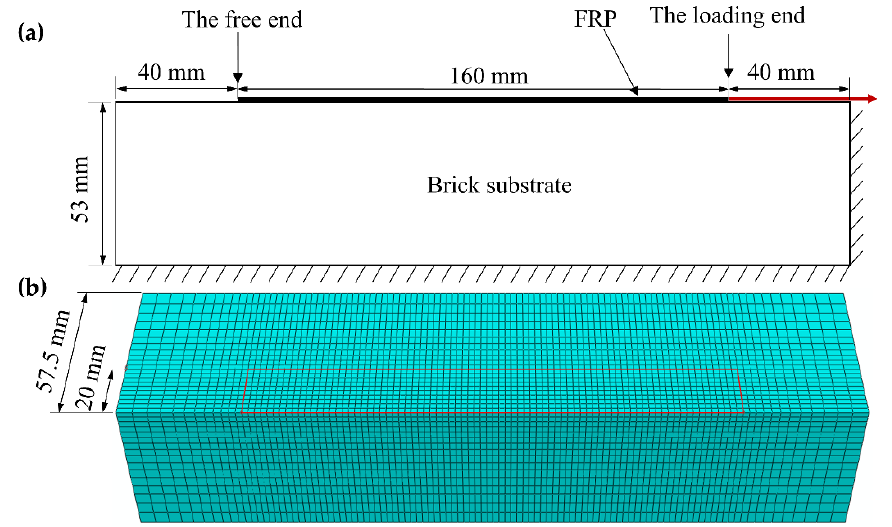
Figure 10. The numerical model of the single-lap shear test: ( a ) boundary conditions; ( b ) mesh.